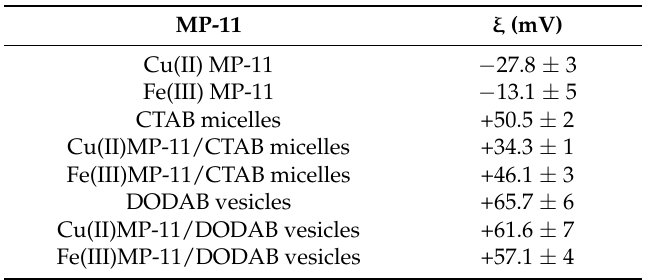
Table 1. Zeta -potential ( ξ ) of DODAB LUVs and CTAB micelles in the presence and the absence of Fe(III) or Cu(II)MP-11.